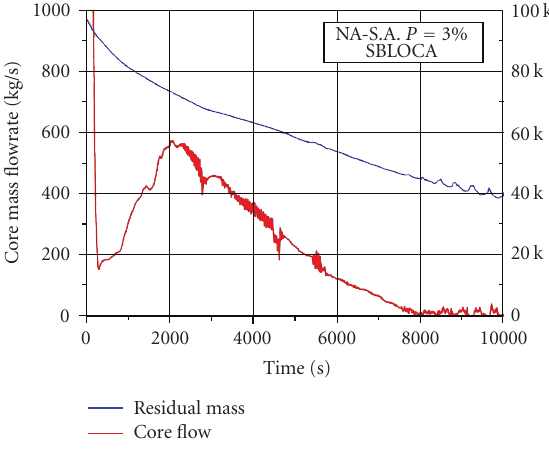
Figure 4: CMFR in a reduced, controlled total mass inventory tran- sient, P = 3%. Nodalization is as shown in Figures 2 and 3.